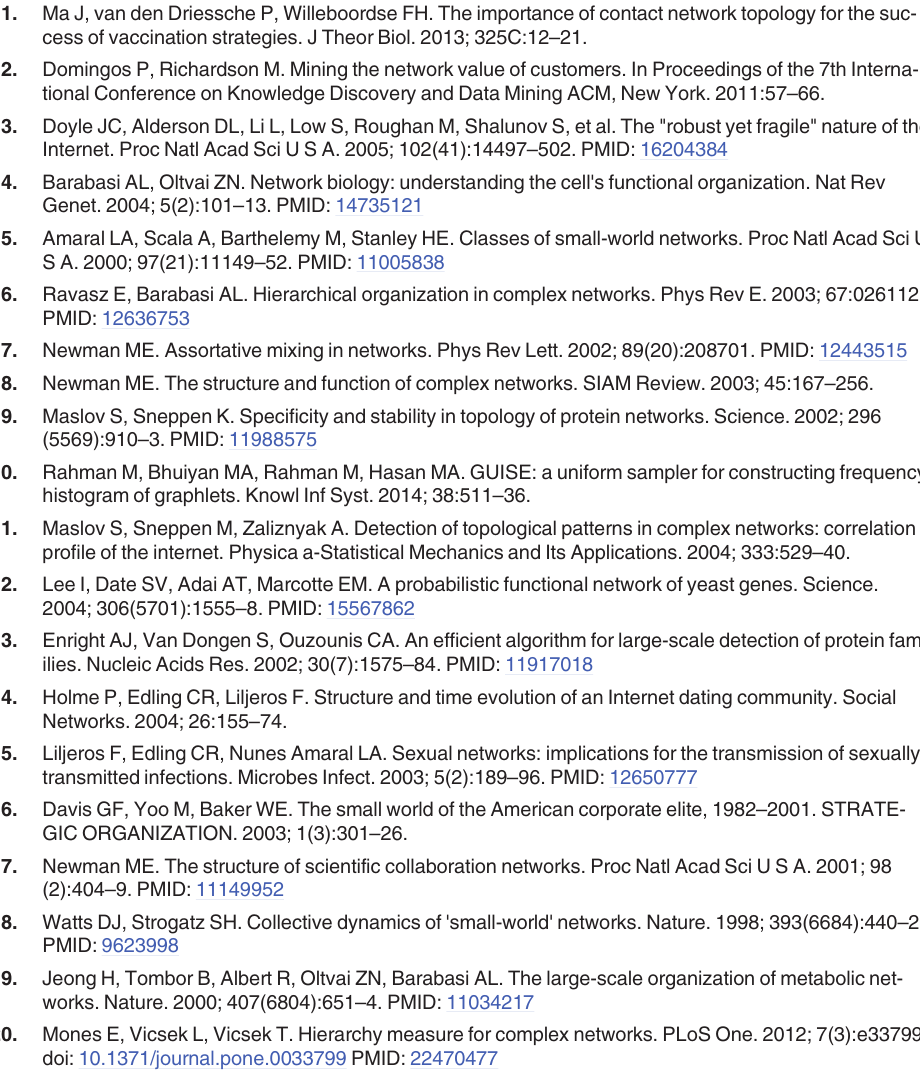
S1 Table. Summary of the networks analyzed in this